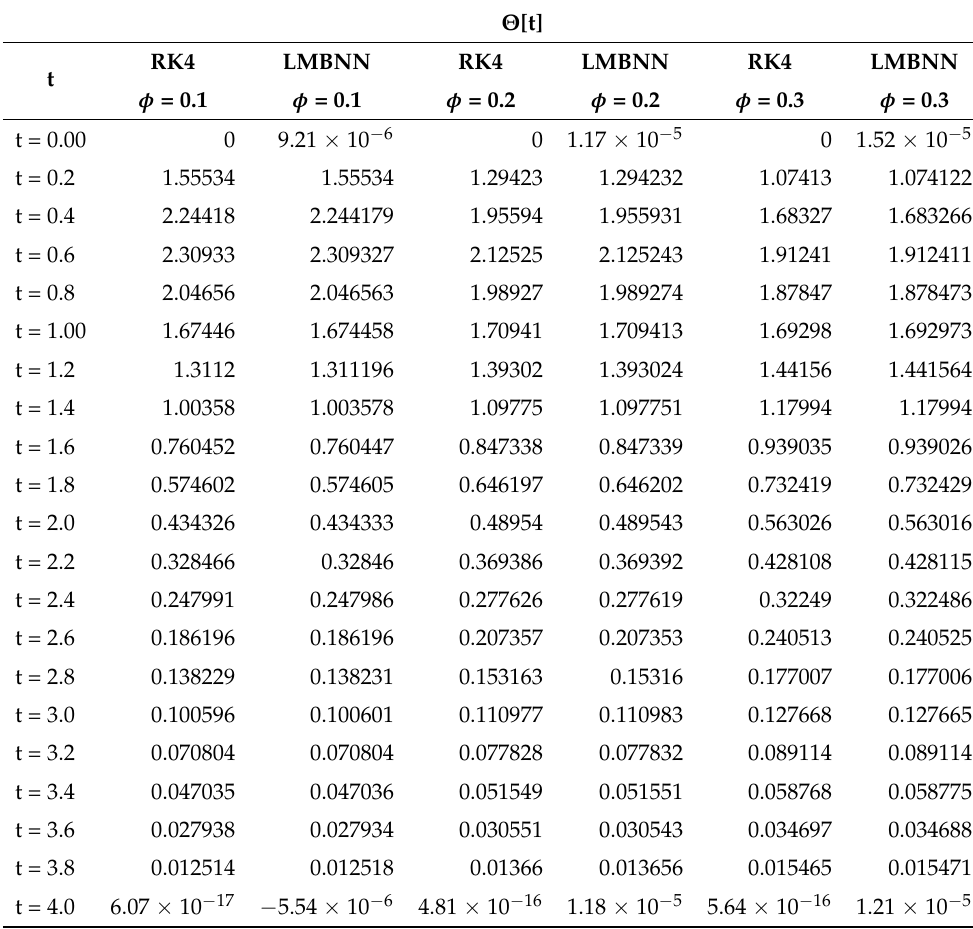
Table 13. Comparison of different values of Θ between RK4 and LMB-NN when φ